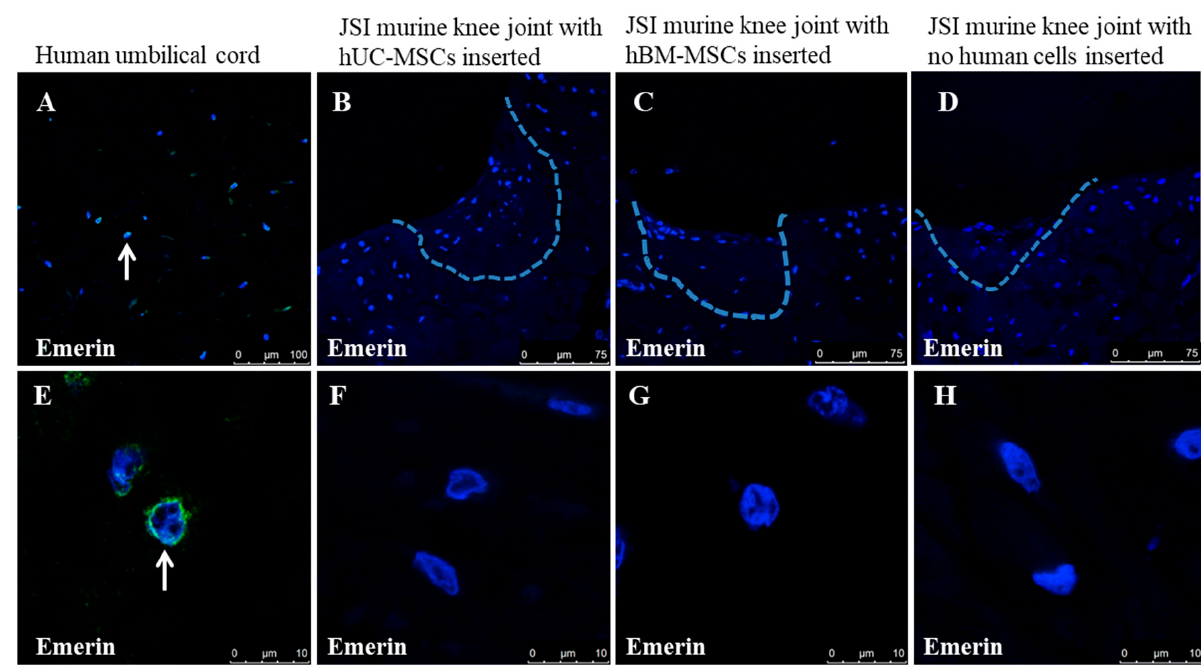
Figure 5. Immunostaining with the human anti-emerin antibody demonstrated ( A , E ) positive cells (arrows) in a section of human umbilical cord, but not in any mouse knee joints ( B – D , F – H ), including those which had human UC-MSCs ( B , F ) or human BM-MSCs ( C , G ) applied.